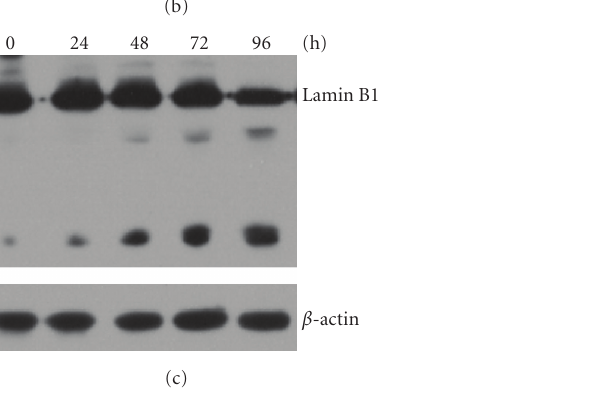
Figure 2: Phenomena appearing after depletion of SOD1. (a) Cell cycle analysis of SOD 1 − / − cells. Cell cycle was analyzed using flow cytometry. Distribution patterns of asynchronous culture of Dox-treated cells for the indicated timepoints. The percentages of cells in each cell cycle phase and dead cells are shown on the right side of each panel. (b) Categorization of Giemsa-stained cells. Cells not having interphase nucleus, mitotic chromosomes, or hypercondensed chromosomes are classified into others in which apoptotic cells are included. Cells were harvested and treated with 75mM KCl and fixed with methanol-acetic acid (3: 1). The cell suspension was dropped onto wet glass slides, air dried, and stained with Giemsa solution (upper row). Percentages of cells exhibiting select phenomena were based on the categorization detailed in the boxes above the micrographs. At least 500 cells were counted in each sample. (c) Western blotting analysis of Lamin B1, with β -actin used as loading